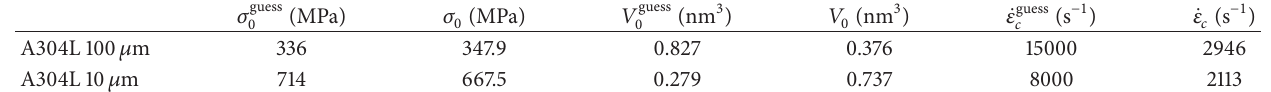
Table 2: Material constants for A304L